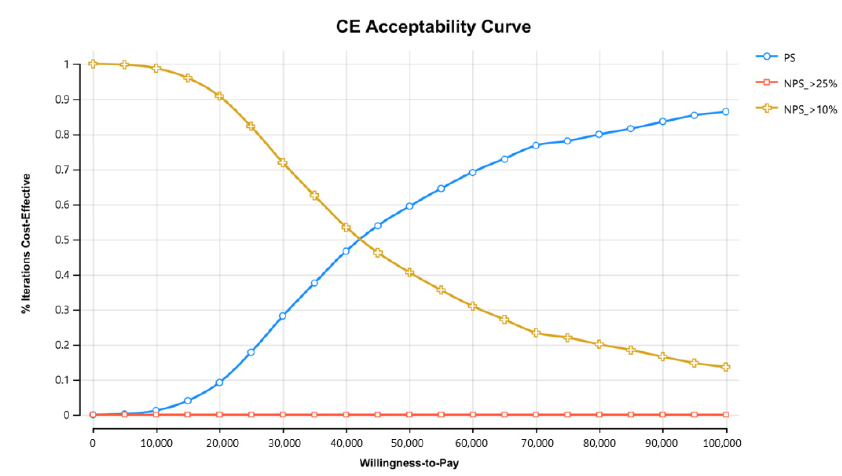
Figure 3. CE (Cost-effectiveness) acceptability curve comparing the three strategies. Probability Sensitivity Analysis using 1000 iterations to compare PS to the other strategies, demonstrated that CT is dominated over all willingness to pay values, resulting from CT’s reduced effectiveness. PS has higher effectiveness, but also higher costs as compared with IFH. As the willingness threshold increases, more iterations result in PS being preferable. PS- Population screening, CT—Cascade testing, IFH—International Family-History based testing.